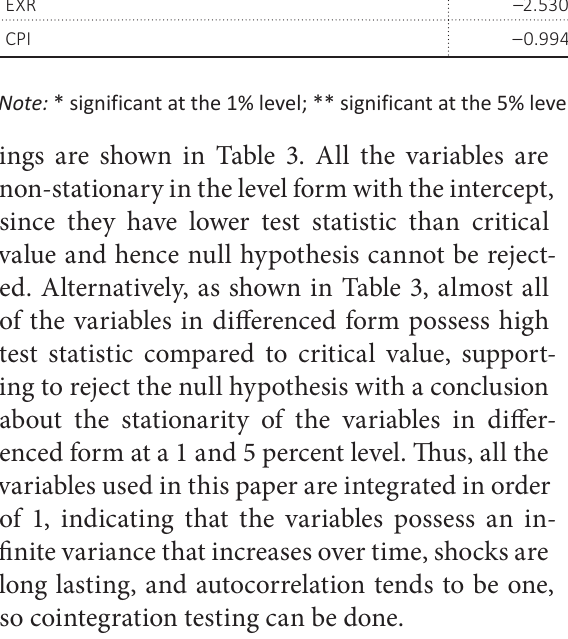
Table 4. Cointegration test for stock indices and macroeconomic variables for